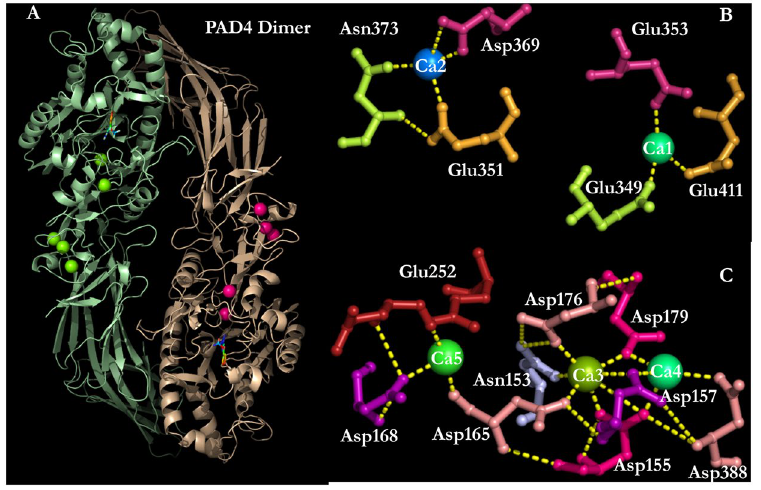
Figure 1. Five Ca 2 + -binding sites in the human PAD4 enzyme. Binding ligands for the five Ca 2 + -binding sites, which include the C-terminal calcium-binding sites, i.e., the Ca1_site and Ca2_site, and the N-terminal calcium-binding sites, i.e., the Ca3_site, Ca4_site and Ca5_site. This figure was generated using PyMOL 50